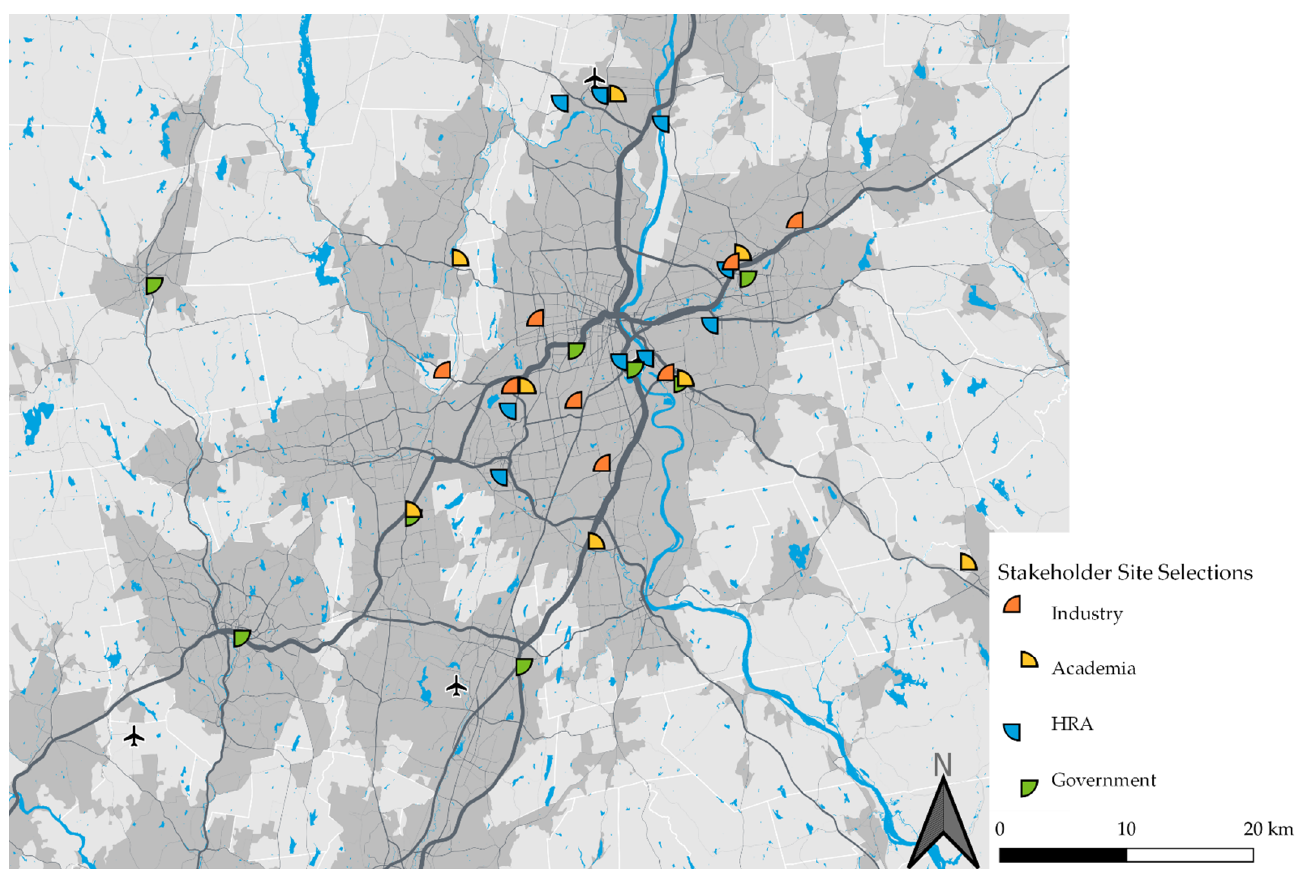
Figure 5. The final HRS network designs of each stakeholder group in Stage 1.